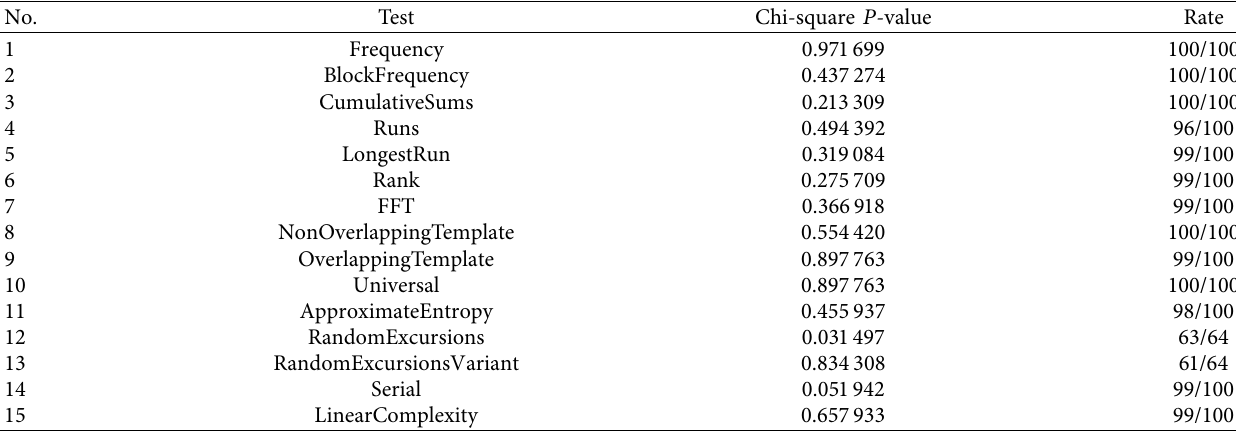
� 0 . 1, A � 0 . 7, B � 0, C � 1, μ � 0 . 2, m � 50). 0